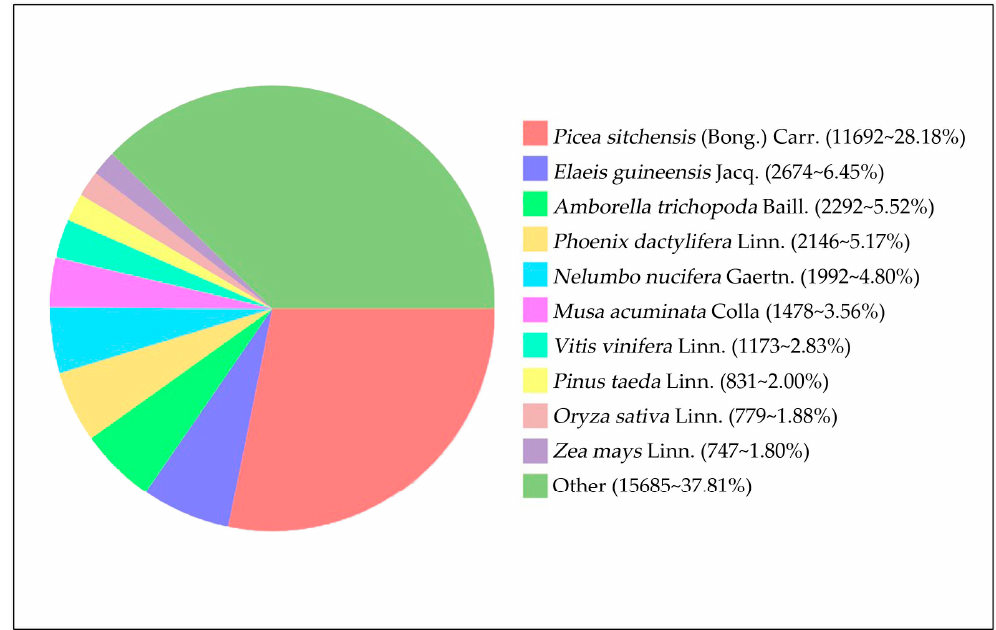
Figure 4. Nr Homologous Species Distribution.